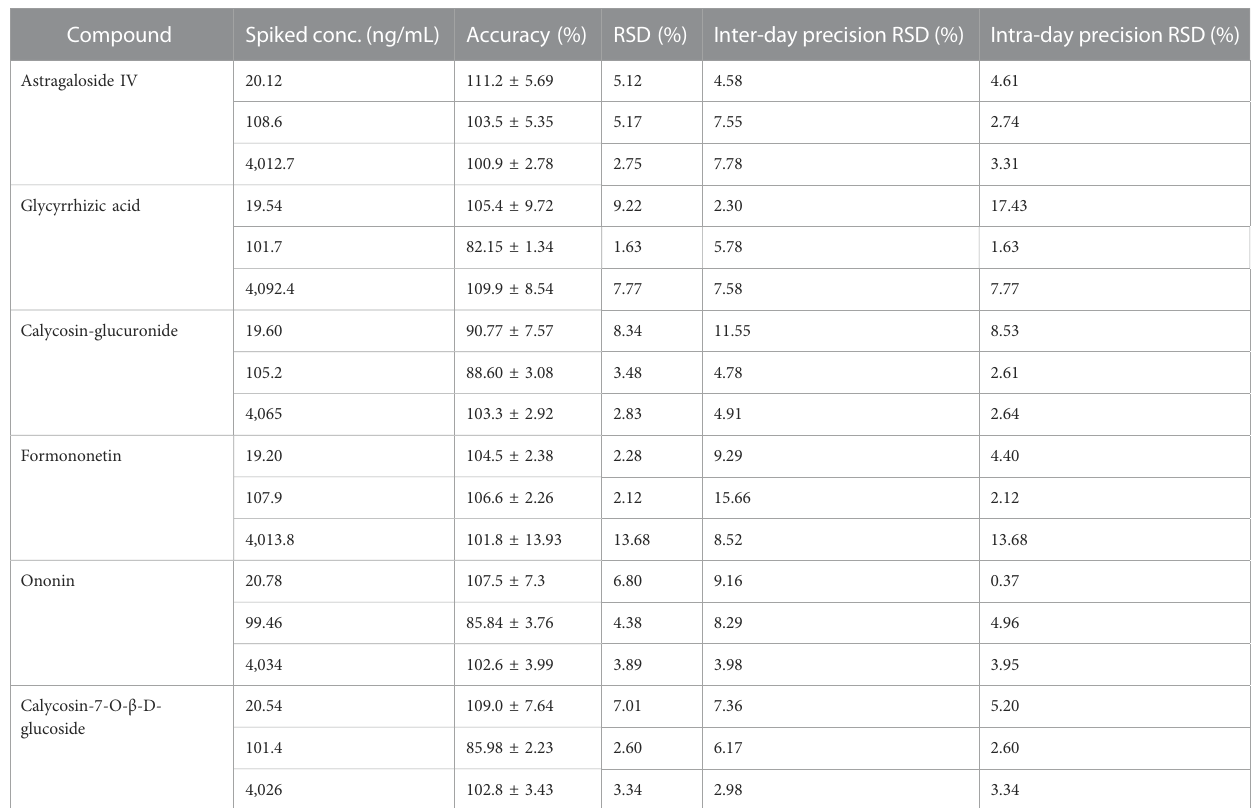
TABLE 4 Accuracy and precision of the six components in liver microsomal samples (x ± SD, n = 6). Compound Spiked conc. (ng/mL) Accuracy (%) RSD (%) Inter-day precision RSD (%) Intra-day precision RSD (%) Astragaloside IV